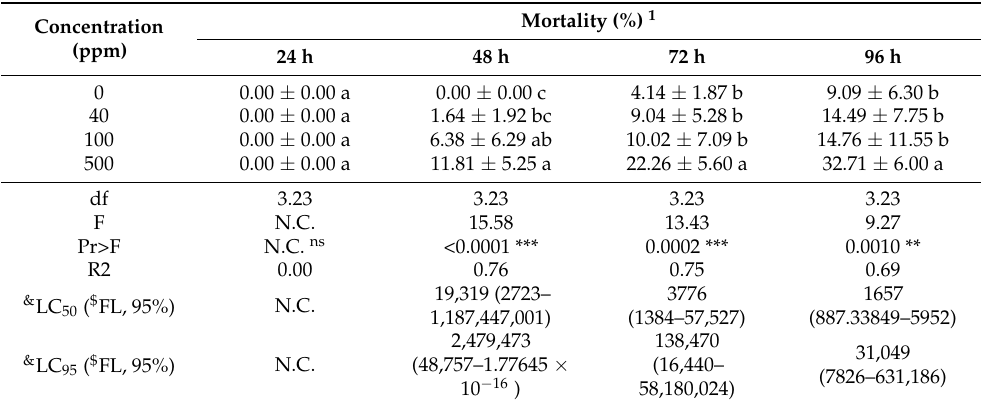
Table 6. Mortality ( ± SD) of tomato psyllid Bactericera cockerelli , at different concentrations of TiO 2 NPs on the greenhouse.